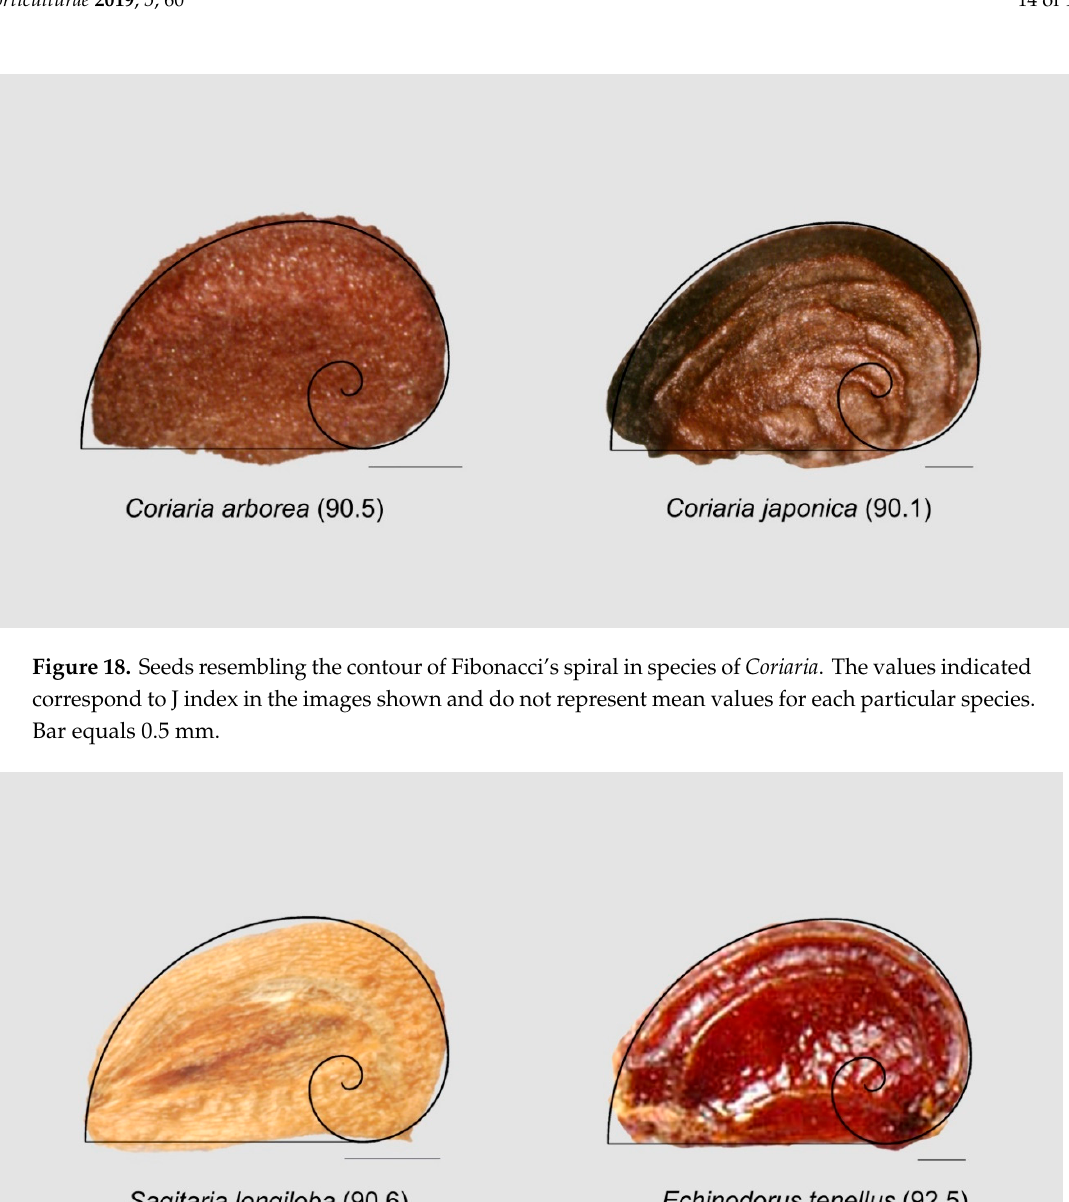
Figure 17. Heart-shaped curves in the Vitales. The values indicated correspond to J index in the images shown and do not represent mean values for each particular species. Bar equals 0.5 mm.